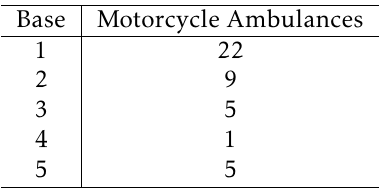
Table 3. Vehicles required per